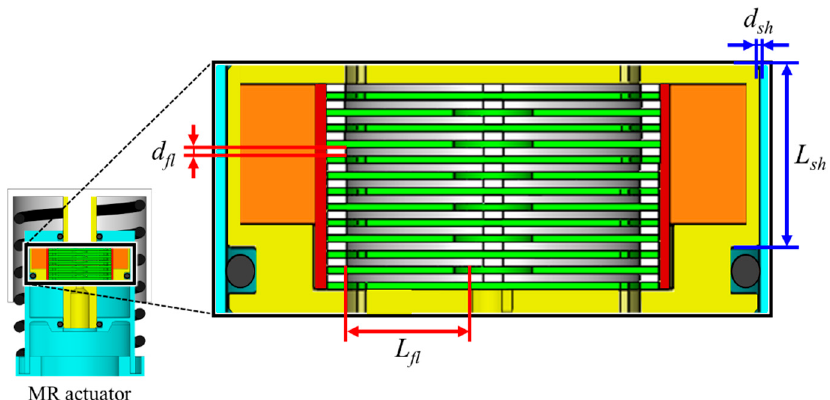
Figure 8. Variables for computing resistive force.